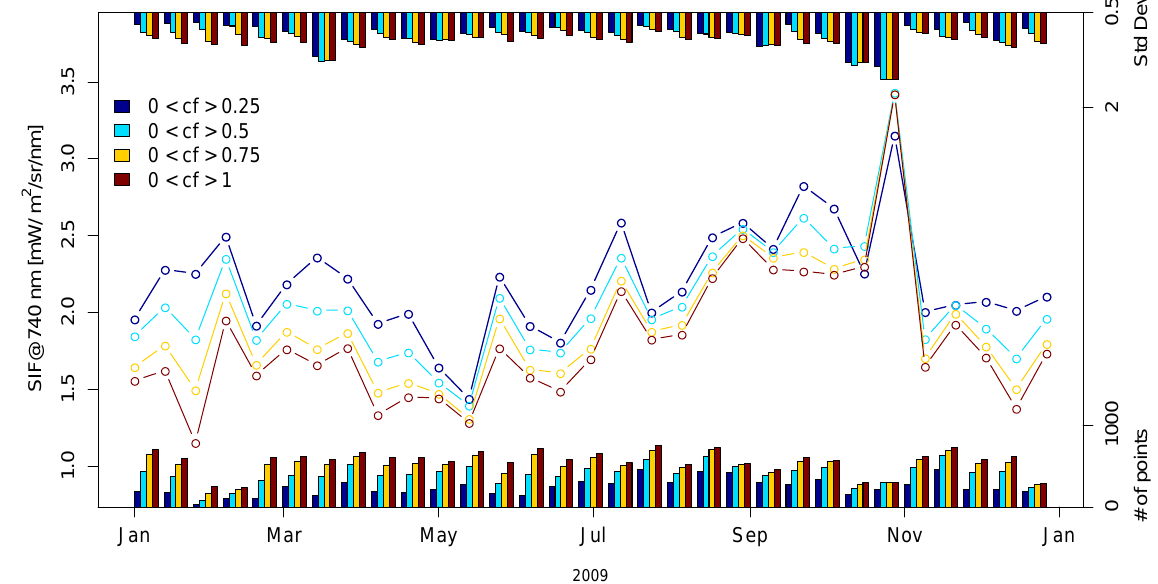
Figure 18. Time series of SIF retrievals from GOME-2 data over a box in the Amazon Basin (70–65 ◦ W, 5–0 ◦ S (shown in Fig. 16), covered with evergreen broadleaf forest) for different cloud fraction thresholds. The time series corresponds to 12day means in 2009. The standard deviation (top) and the number of included retrievals (bottom) per time step are depicted as bar